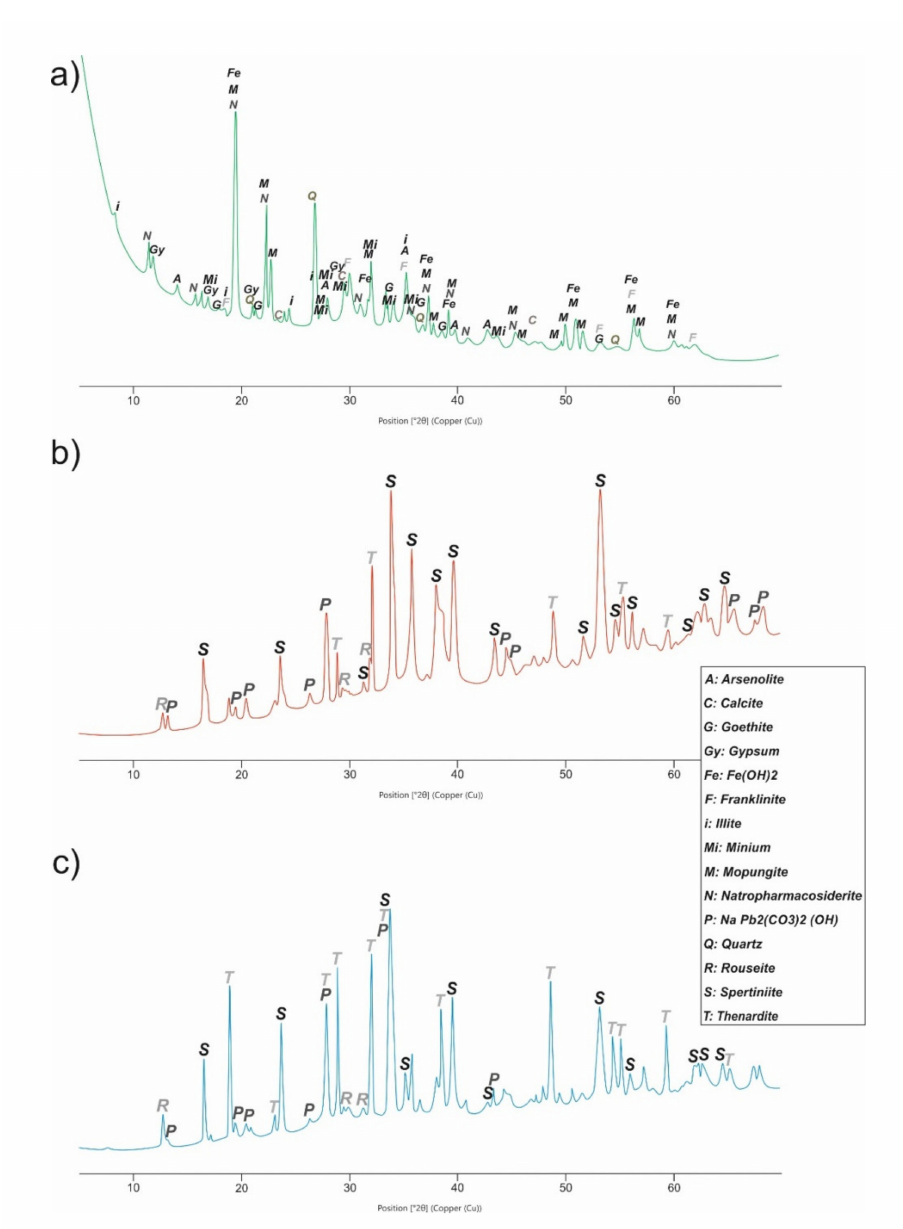
Figure 3. X-ray diffractograms obtained for the facility waste. ( a ) SM-WAS sample. ( b ) Blue precipitates. ( c ) Greenish and whitish